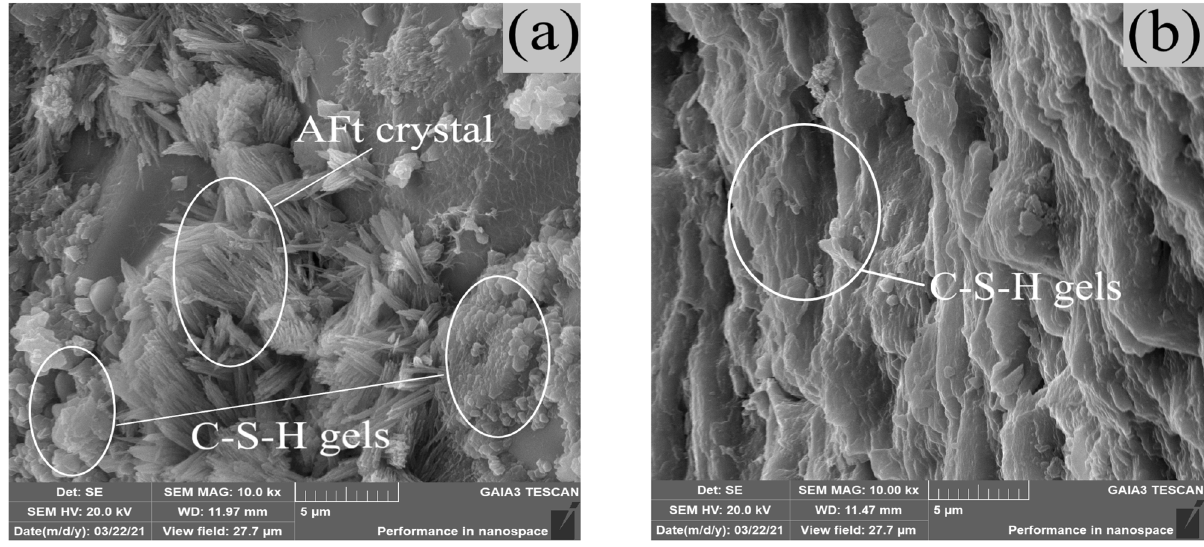
Figure 7: Hydration products: ( a ) C and ( b ) SSC 20 – 60 .